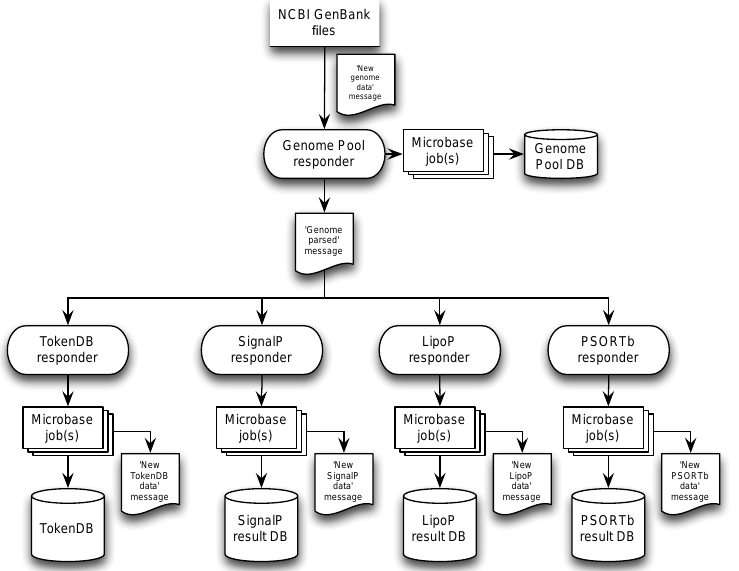
Figure 1: The integration and dataset generation pipeline, ApID1. NCBI GenBank-format files are inserted, parsed and indexed into a database (the GenomePool). This process triggers the execution of a number of analytical tasks that run in parallel: the tokenization of each protein sequence and the sub-cellular localization analysis of each protein. This upstream pipeline is used to generate several datasets that form the basis for further token